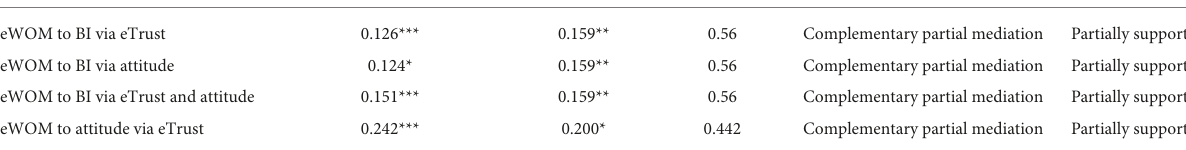
TABLE 7 Multiple mediation analysis.